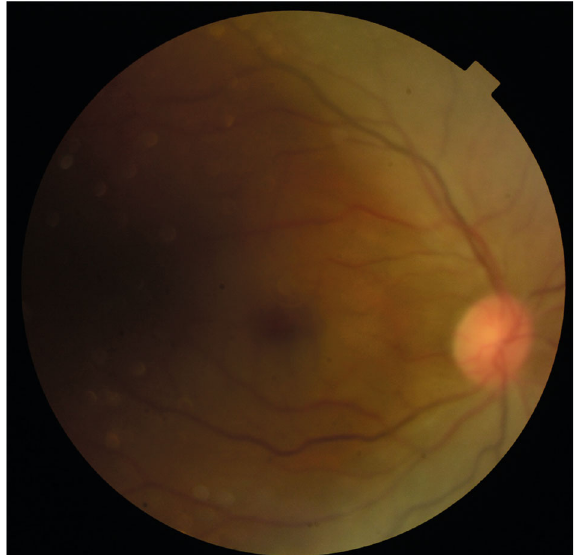
Figure 1: Retinal edema with arteriolar attenuation and cherry spot appearance in the right